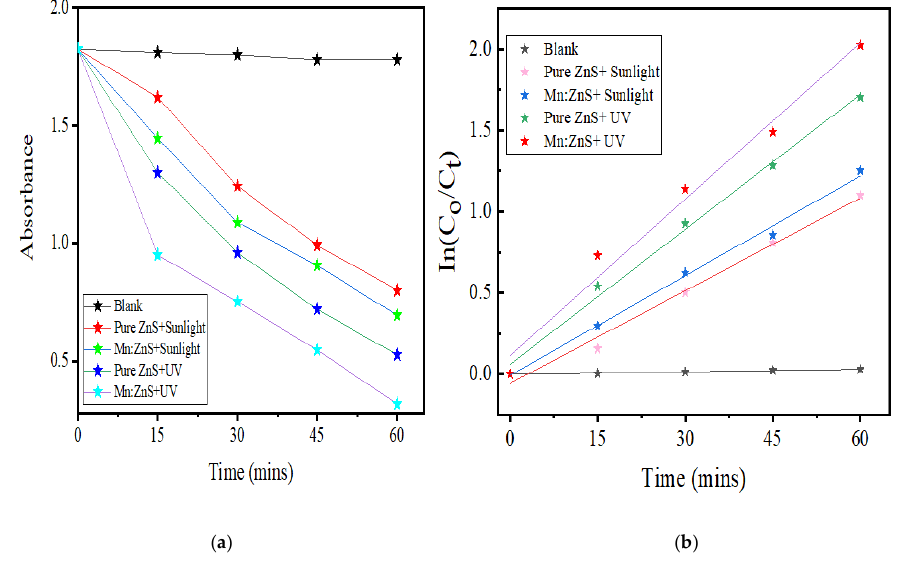
Table 2. The photocatalytic activity of synthesized pure ZnS and Mn:ZnS QDs under UV light and natural sunlight can be assessed by comparing the apparent rate constants. Thus, it can be seen that the photodegradation e ffi ciencies of pure ZnS and Mn:ZnS QDs as catalysts under UV light illumination are higher than under natural sunlight irradiation. Nanomaterials 2020 , 10 , x FOR PEER REVIEW